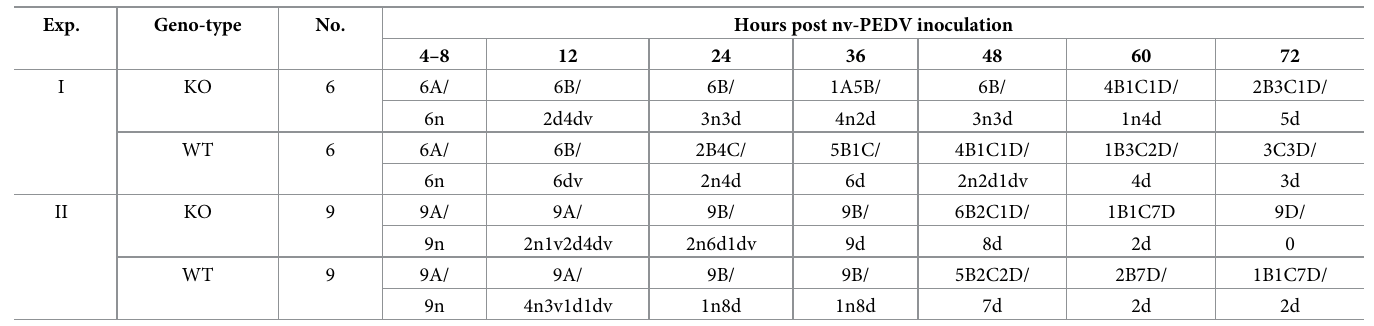
Note: No. of piglets with viability and clinical signs: viability—A is normal, B indicates decreased activity, C is moribund, and D indicates dead; clinical signs—n indicates no clinical signs, d is diarrhoea, and v is